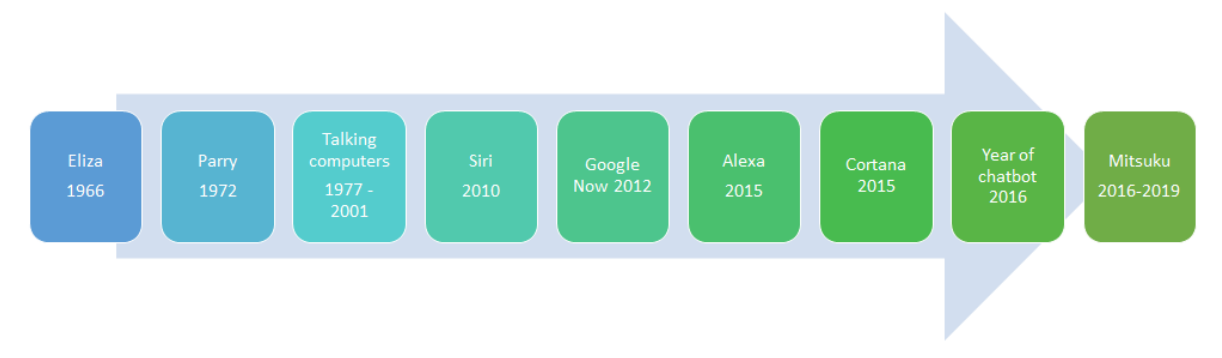
Figure 1. Evolution of conversational agents from 1966 to